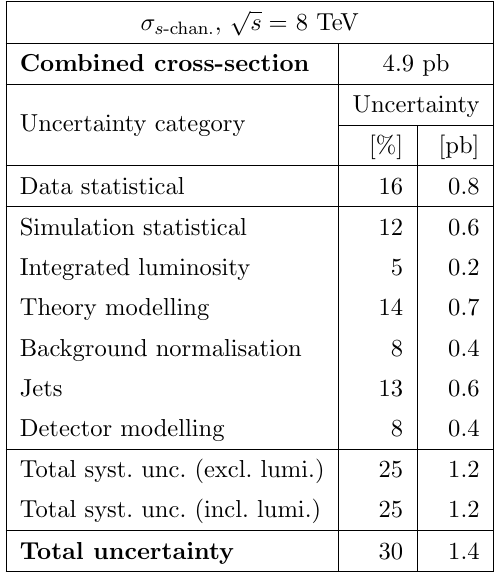
Table 5 . Contribution from each uncertainty category to the combined s -channel cross-section ( (cid:27) s -chan. ) uncertainty at p s = 8 TeV. The total uncertainty is computed by adding in quadrature all the individual systematic uncertainties (including the uncertainty in the integrated luminosity) and the statistical uncertainty in data. Correlations of systematic uncertainties between experiments are presented in appendix